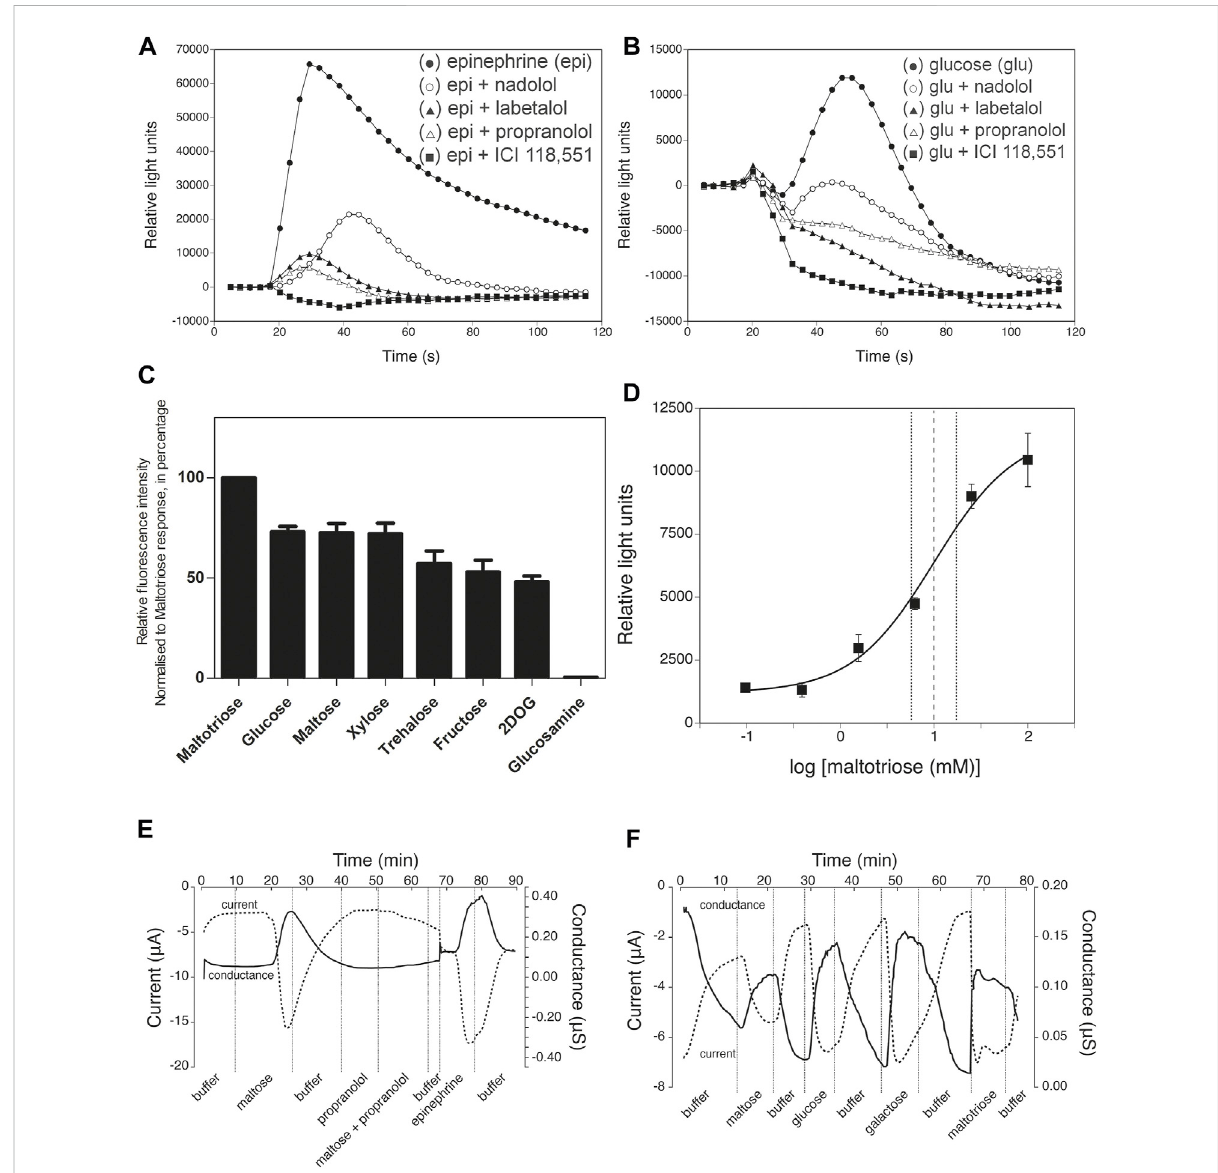
FIGURE 2 Inhibitionby β -ARantagonists,sugarspeci fi cityandaf fi nityof β 2 -AR. (A) Epinephrine-(20 nM,black fi lledcircle)and (B) glucose-(70 mM,black fi lled circle) induced responses and their inhibition by pre-incubation for 50 min together with the Fluo4 compound with various β -AR antagonists (all at 200 μ M): nadolol ( β 1,2 -antagonist, white open circle), labetalol ( α , β -antagonist, black fi lled trangle), propranolol ( β 1,2 -antagonist, white open triangle) and ICI 118,551 ( β 2 -antagonist, black fi lled square) of β 2 -AR expressed in Flp-In-293 cells. Addition of agonists was done at time zero, 17 s after the start of the recording of the calcium signals generated. Note the difference in Y -axis scale between (A) and (B) . Representative results from at least three repetitions are shown. (C) Speci fi city of the response to different sugars added at 50 mM. In all cases, except for 2-deoxyglucose (2DOG), the responses were completely blocked by 1 µM ICI 118,551. For 2DOG, only the response blocked by ICI 118,551 is shown. The y -axis displays peak fl uorescence intensity (arbitrary units) for the response to the different sugars. All values are expressed as mean ± SD ( n = 3; technical replicates). (D) Dose-response curve for maltotriose activation of the β 2 -AR expressed as Relative Light Units as a function of the log maltotriose concentration. The EC 50 is approximately 10.00 mM. Maltotriose was used instead of glucose because of rapid uptake of glucose in the cells, while maltotriose is not taken up by the HEK Flp-In 293 cells. The derived curve is the result of 3 independent, biological repeats. The dashed vertical lines indicates 95% con fi dence interval on the calculated EC 50 . All values are expressed as mean ± SD. (E) Maltose and epinephrine responses of β 2